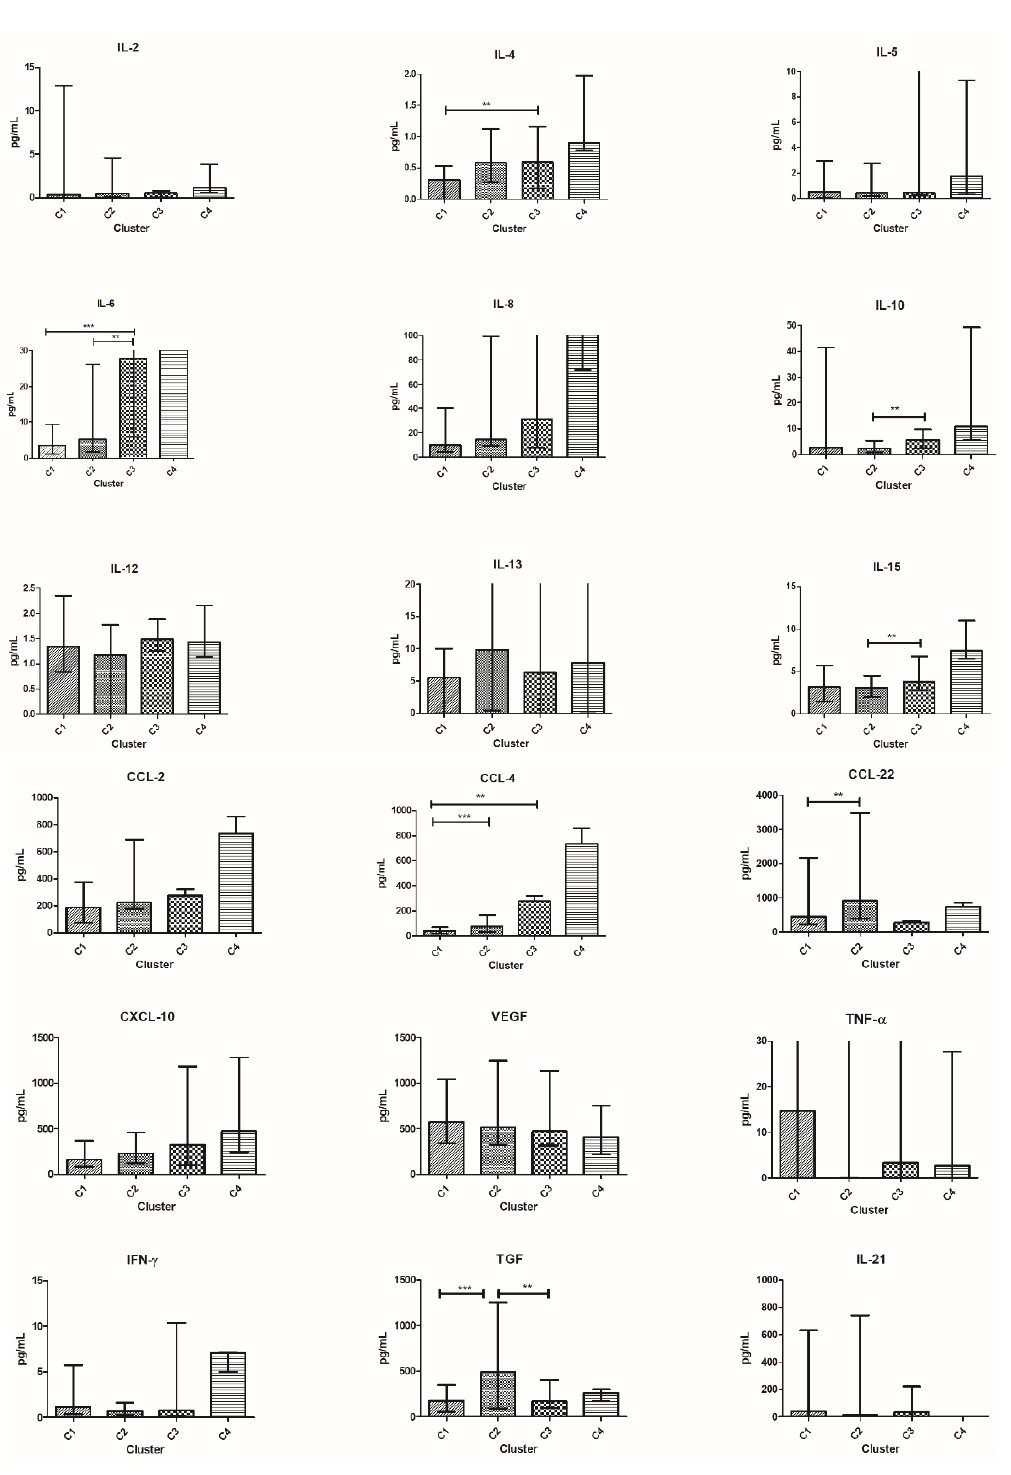
Figure 7. Cytokine distribution at T 1 in the four clusters. Cytokine concentration in plasma is expressed in pg/mL and plotted on the y -axis; clusters of patients are on the x -axis. For TNF- α , IL-5, IL-6, IL-8, and IL-13 outliers are not shown for graphical choice. Data are expressed as median with range. *** p < 0.001, ** p < 0.01, * p < 0.05. CCL, C-C motif ligand; IL, interleukin.